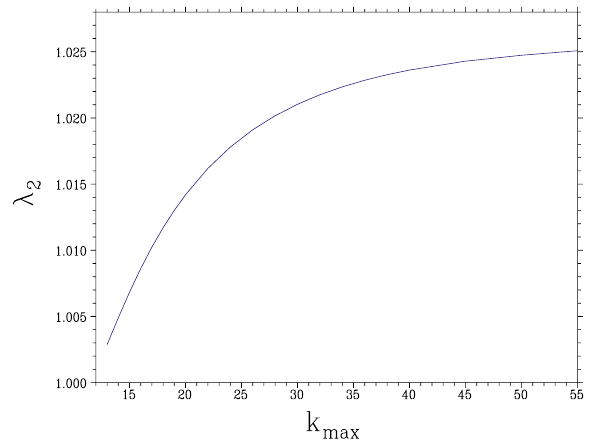
FIG. 6. (Color) The second p -mode eigenvalue for R (cid:1) 0 as a function of the truncation of Hermitian